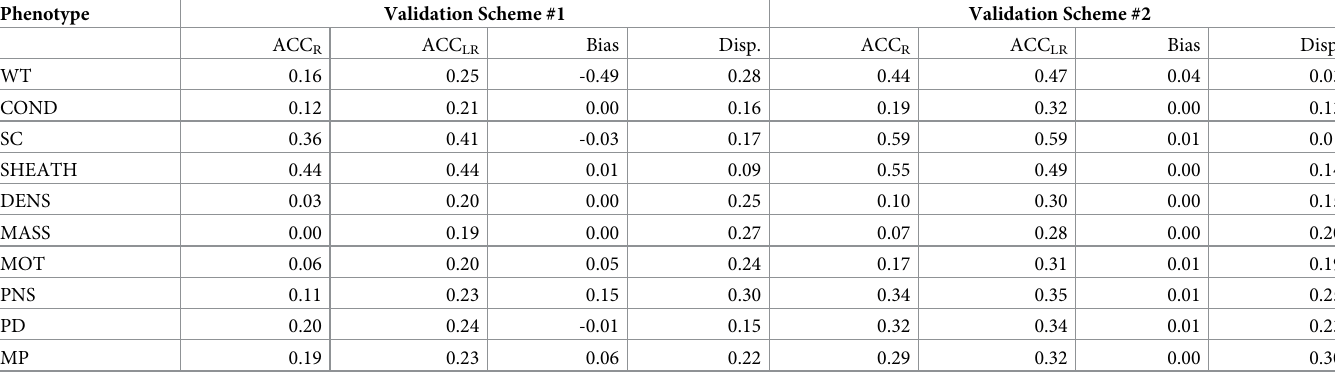
Table 3. Accuracy, bias and dispersion of GEBV across the 10 phenotypes averaged across the 6 breeds and by two validation schemes.